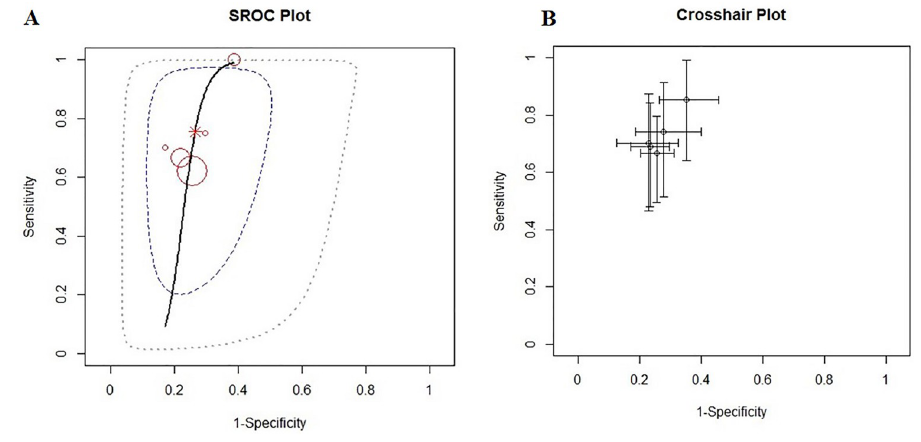
Fig 5. Summary ROC curve (A), and cross air plot (B) for POD3.